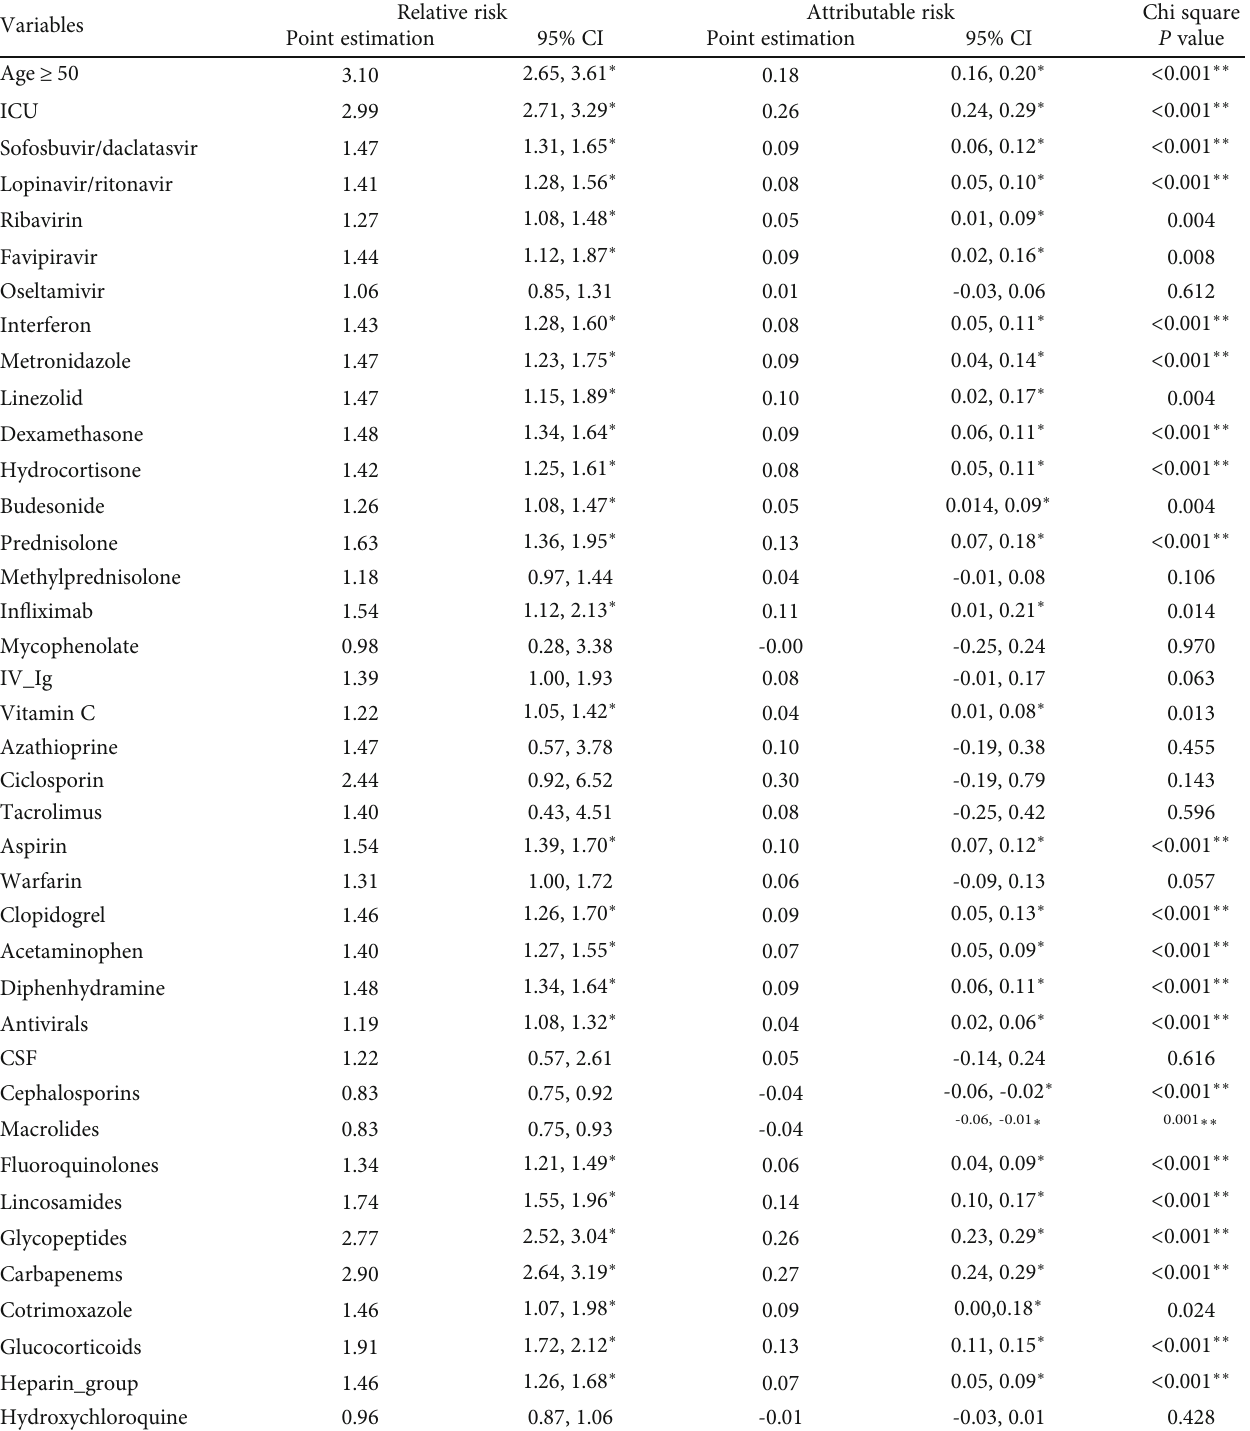
Table 2: Association of the variables with risk of death (in hospitalized improved or dead cases, the other cases were removed).